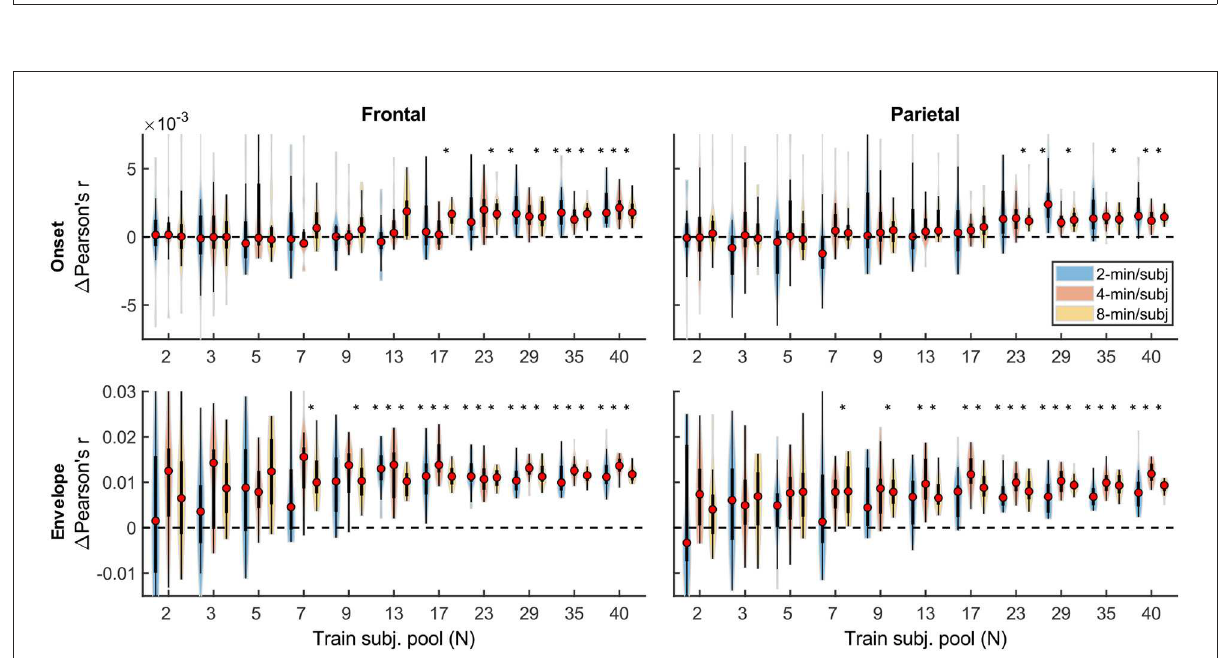
FIGURE10 Feature-specific generic model contributions as a function of training subject pool size, for the denser model, with 2-, 4-, and 8-min of training data per subject (violin color; see legend in the upper right plot). Asterisks denote significance levels as in Figure